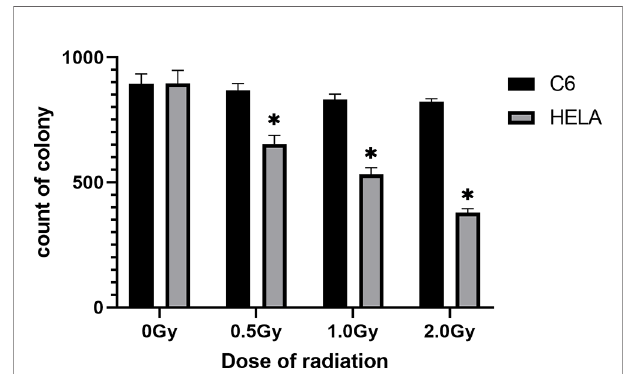
FIGURE 3 | Quantitative analysis of the numbers of colonies formed by different groups of cells. Data shown are means from three independent experiments. Hela data are from Liu et al. (21). * p < 0.05 vs. control or other